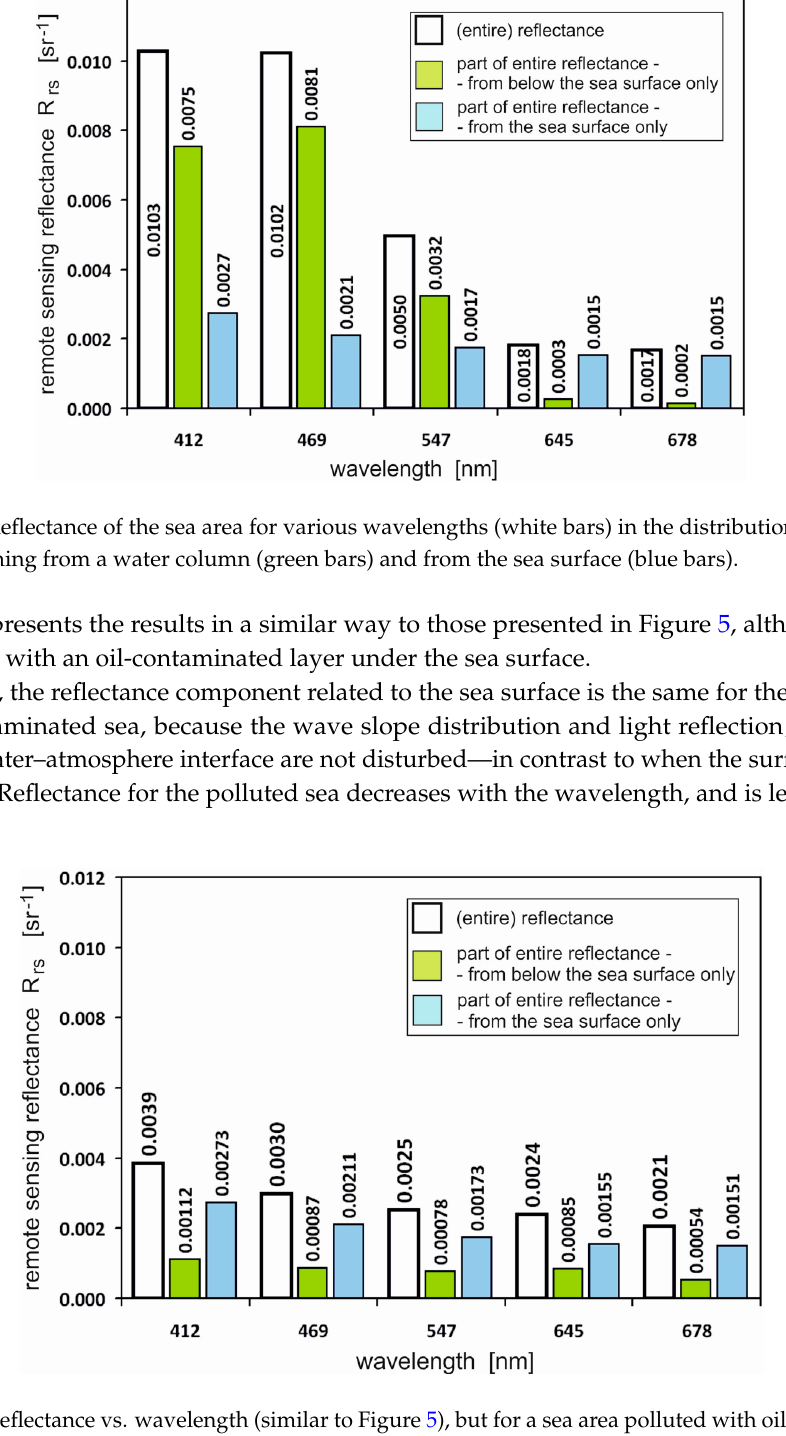
Figure 6. Reflectance vs. wavelength (similar to Figure 5), but for a sea area polluted with oil (as shown in Figure 1).